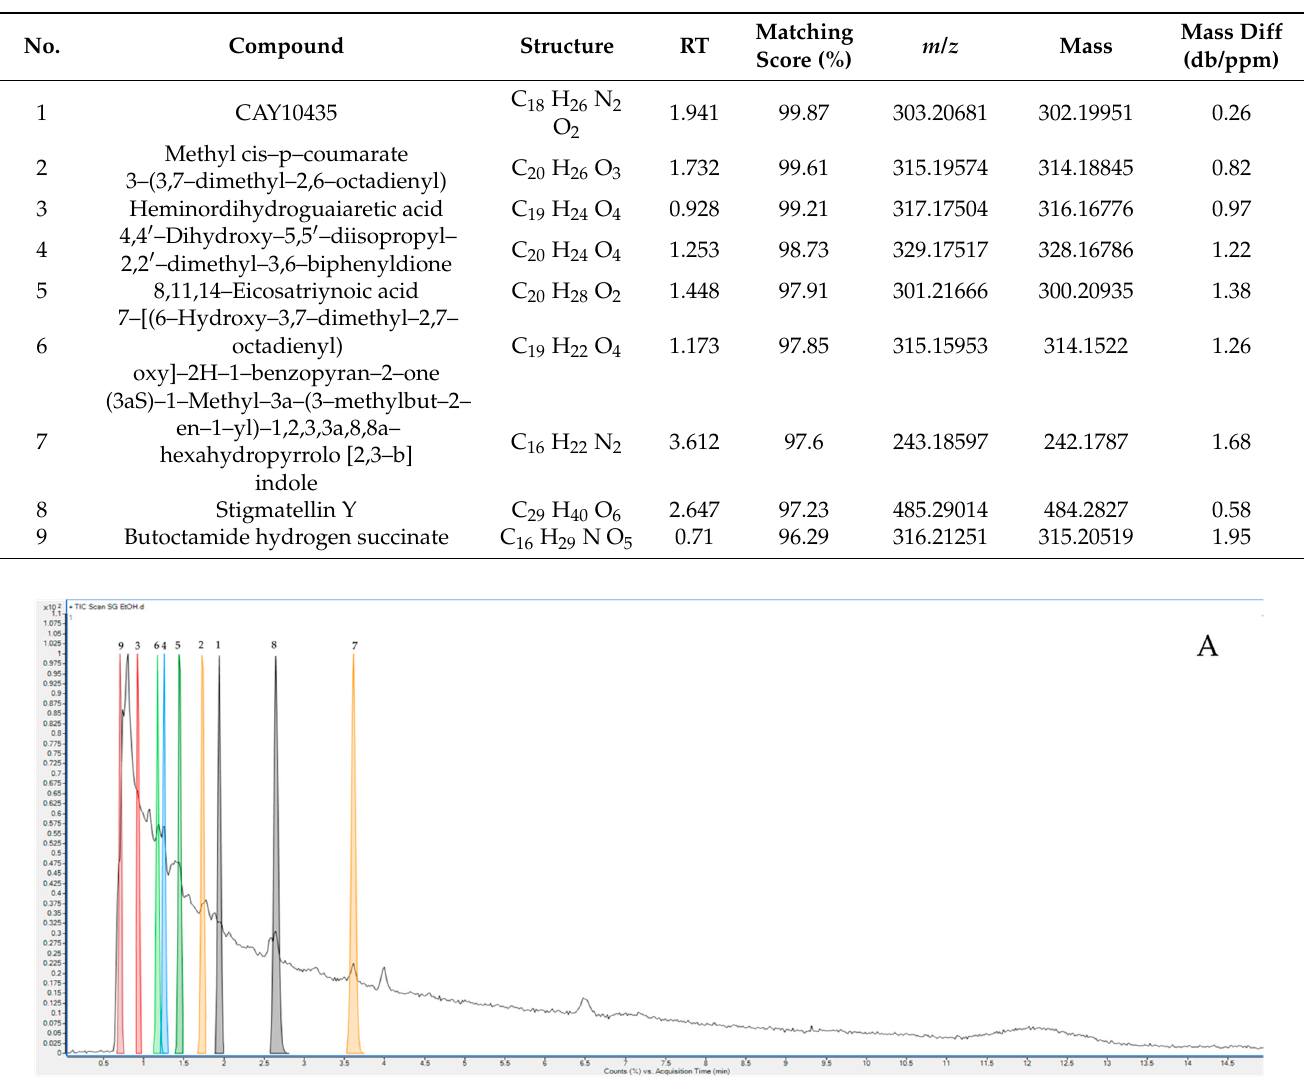
Table 2. Compounds identified from the ethanolic extract of S. glabra crude according to LC-QTOF-MS.